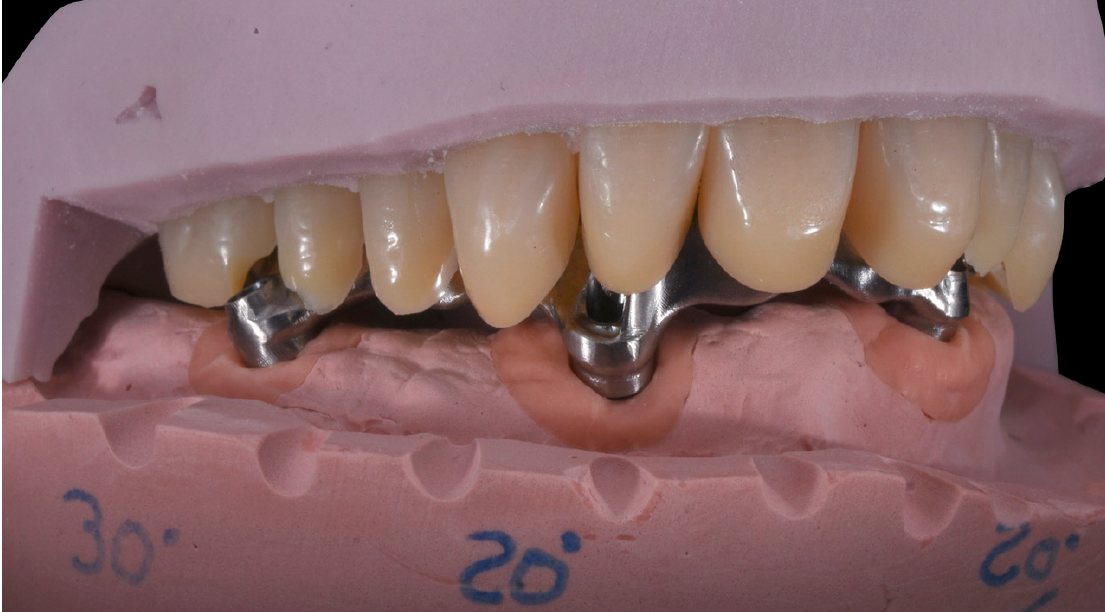
Figure 8. Silicone masks to evaluate prosthetic spaces.